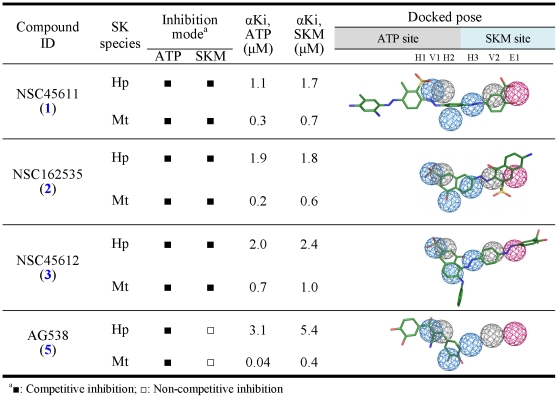
Properties of some potent inhibitors of HpSK and MtSK.Docked poses of NSC45611, NSC162535, and NSC45612 are located at the ATP site (H1, H2, and V1) and the shikimate site (H3, V2, and E1), and these inhibitors are competitive inhibitors of ATP and shikimate (SKM). AG538 is a competitive inhibitor of ATP, in agreement with its docked pose.